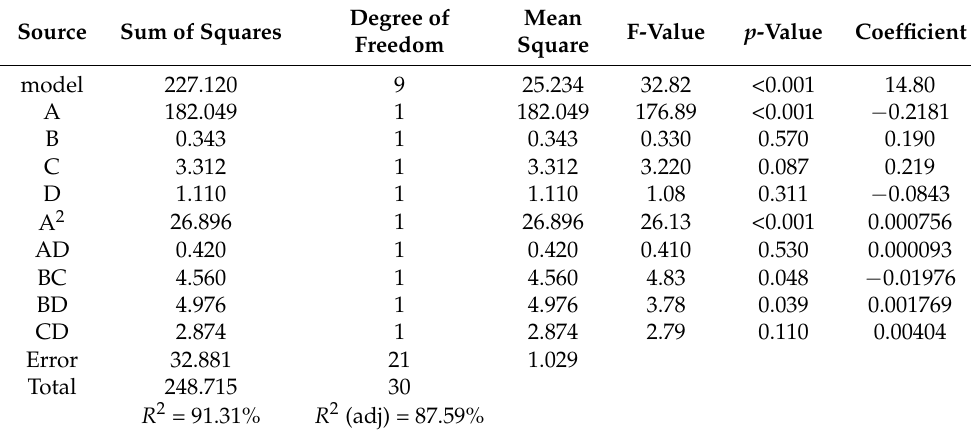
91.31% and 87.59%. The reduced multiple regression model for EWR mf is expressed in Equation (9). Table 6. The ANOVA of the reduced regression model for electrode wear ratio (EWR) of EDM with multi-aperture flushing. Degree Source Sum of Squares Mean Square F-Value p -Value Coefficient of Freedom